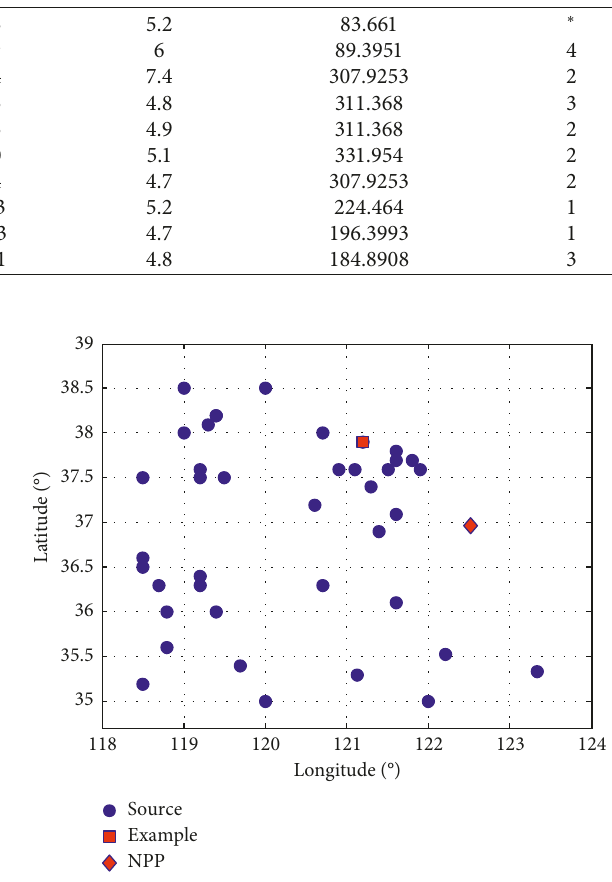
Figure 5: Earthquake distribution (regional scope: 118.5 ° –124 ° east longitude and 35.0 ° –38.5 ° north latitude; time range: 70 BC–May ≥ 4 . 2006; magnitude range: M s